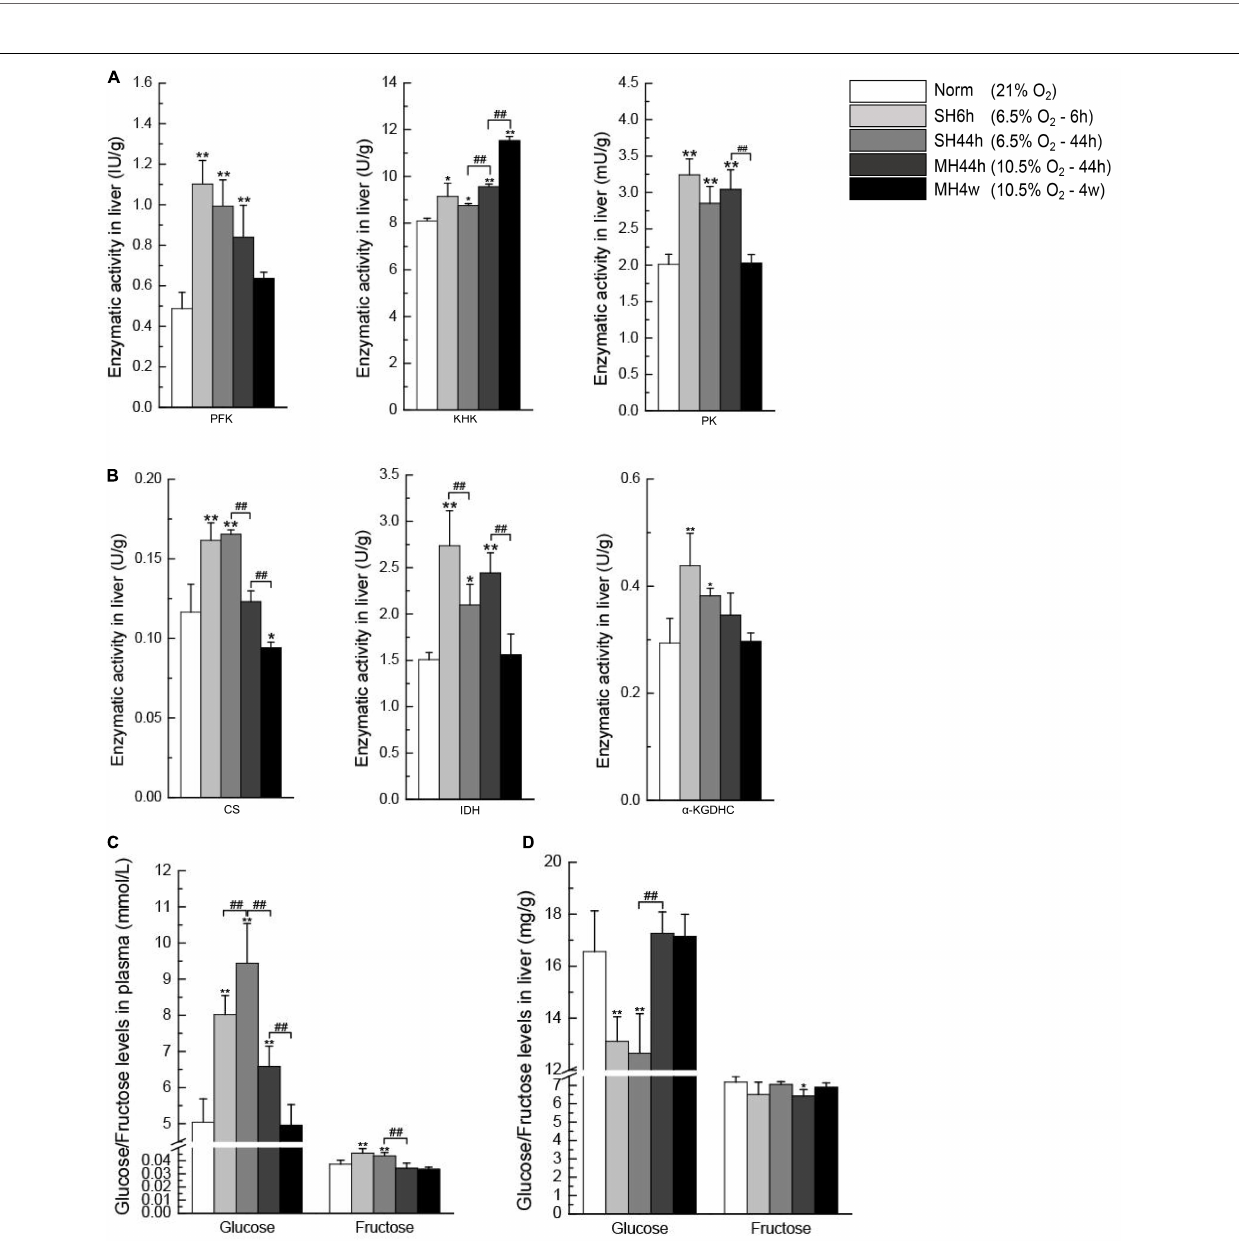
of carbohydrate-related metabolism of Gansu zokor liver under different hypoxia